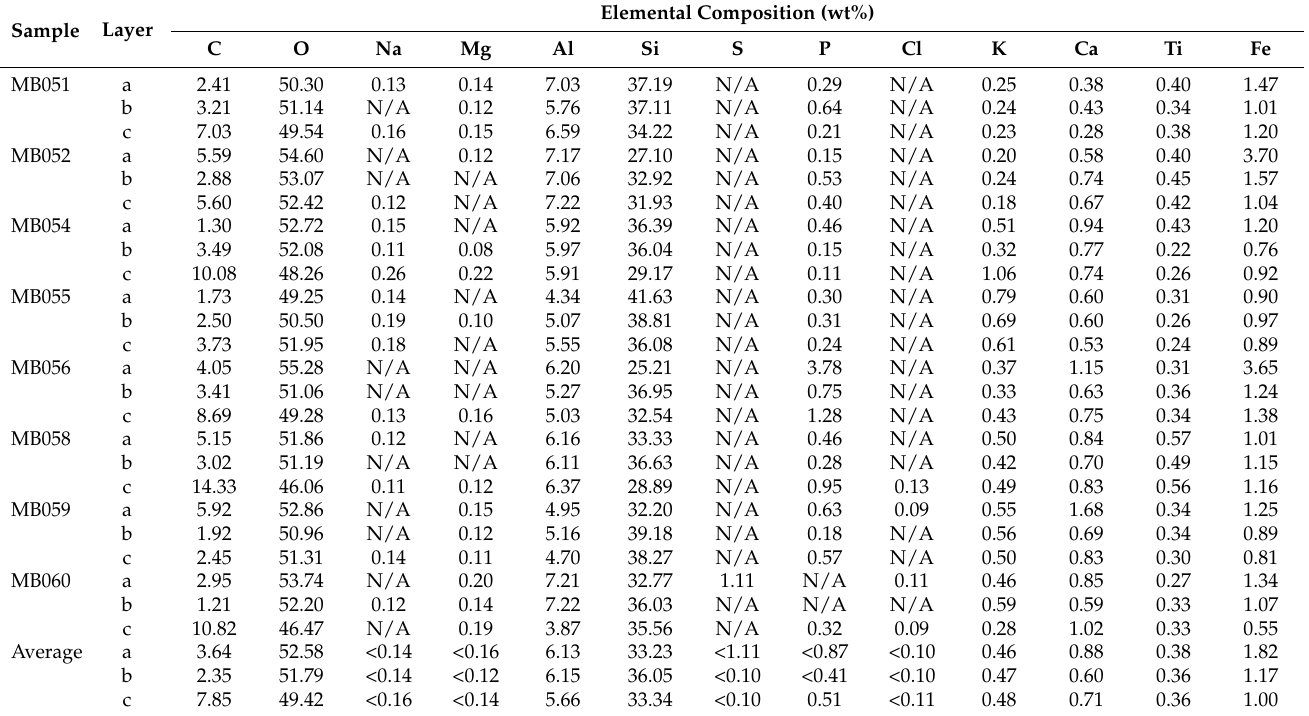
Table 2. Elemental composition of the burial potsherd samples collected from Ban Muang Bua probed by SEM-EDS in (a) outer layer, (b) core, and (c) inner